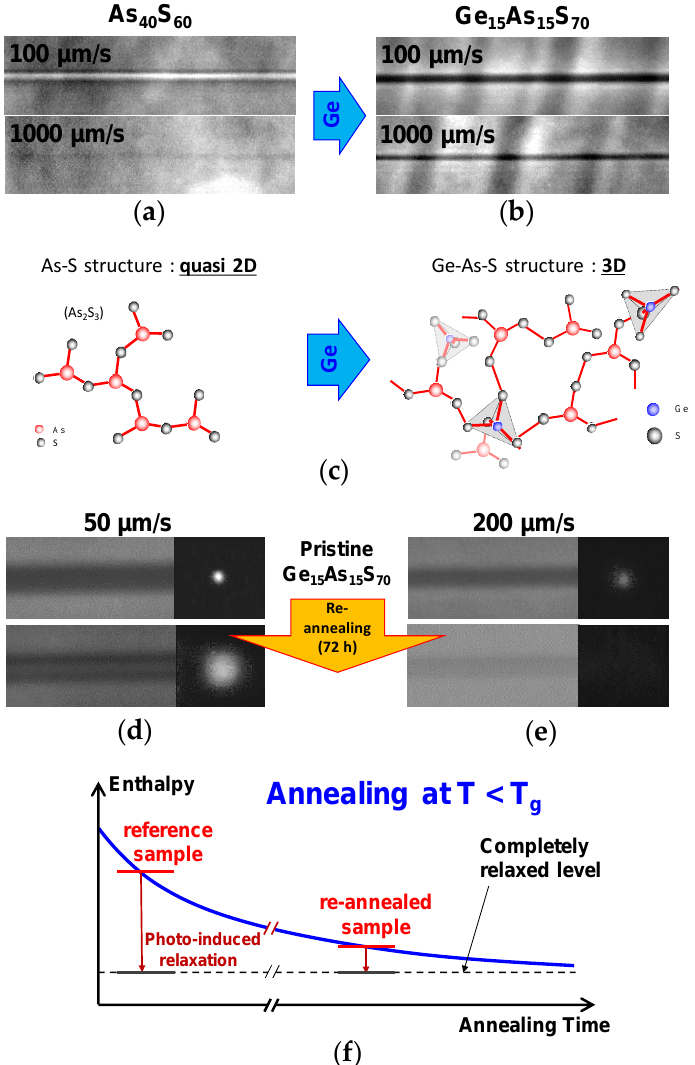
Figure 5. Comparison of the refractive index change results (PCM) of the waveguide laser photo- inscription process in ( a ) As 2 S 3 and ( b ) Ge 15 As 15 S 70 glasses with the same laser parameters (2 mW (@100 kHz) and 160 fs duration) and for two different scanning speeds. The translation speeds of the samples are indicated on the images; ( c ) A quasi planar As-S molecular structure acquires a 3D connectivity (Ge-As-S) after doping with Ge, increasing its structural flexibility; ( d , e ) Comparison of the index change results (PCM) of the waveguide photo-inscription process in a pristine (top) and longtime re-annealed (bottom) Ge 15 As 15 S 70 samples by 2 mW (@100 kHz) and 160 fs laser pulses, with two different scanning speeds. The translation speeds are indicated on the top; ( f ) Schematic of the thermal history of annealed chalcogenide glasses and its influence on the enthalpy of the microscopic glass structure.